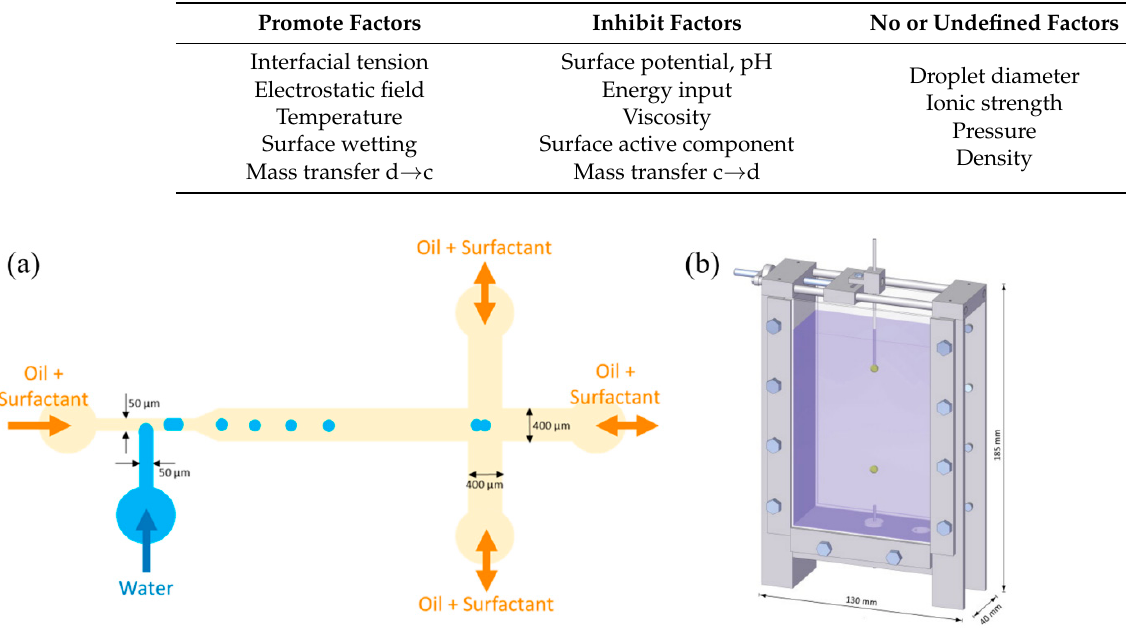
Figure 4. Some typical devices for droplet coalescence studies. ( a ) Microfluidic device; ( b ) coalescence cell. Reprinted with permission from Ref. [87]. 2020, ACS (American Chemical Society). Reprinted with permission from Ref. [89]. 2014,